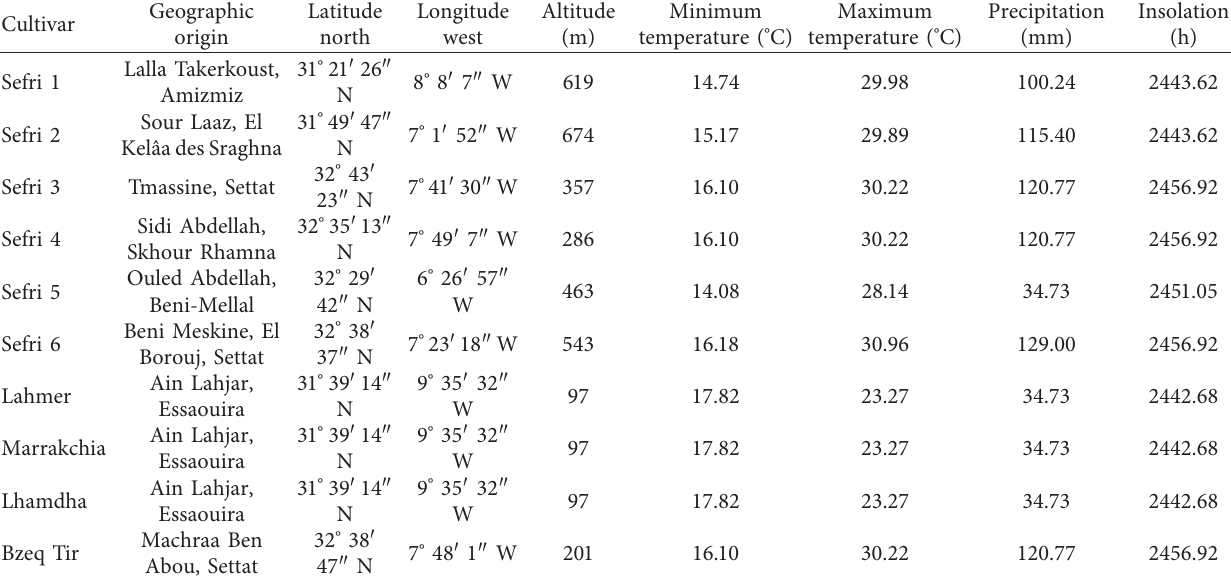
Table 1: Geographic origins and environmental conditions of pomegranate fruits of ten Moroccan cultivars. Cultivar